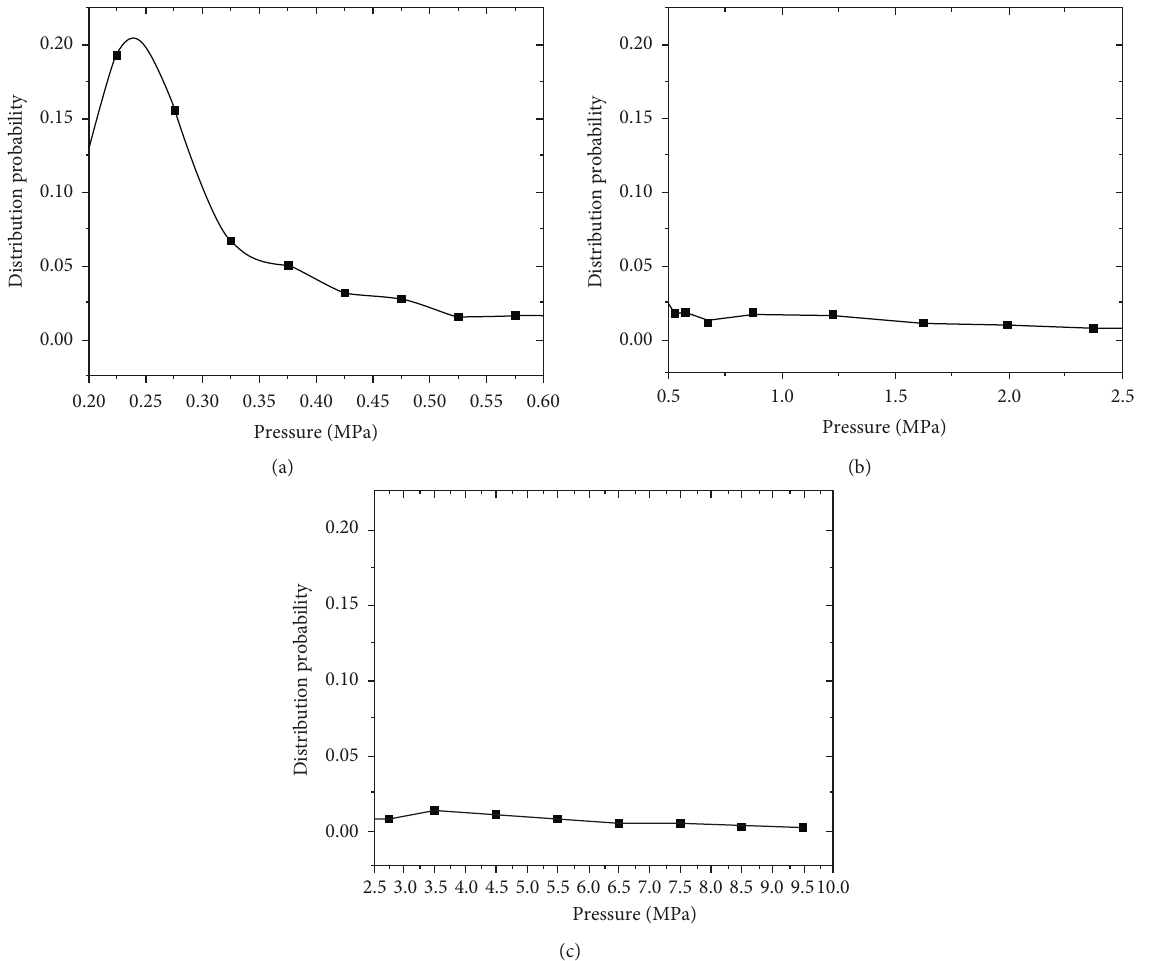
Figure 3: Pressure distribution at three levels: (a) LLLW, (b) LLW, and (c) LW.